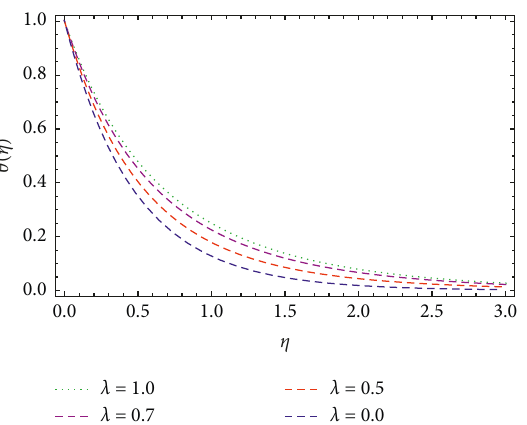
Figure 12: The influence of the velocity profile for different values of a ∗ ,b ∗ , when K � 0 . 1 , β � 0 . 4 , Pr � 5 . 0 ,E c � 0 . 4 , λ � 0 . 2 , and f w � 0 . 3